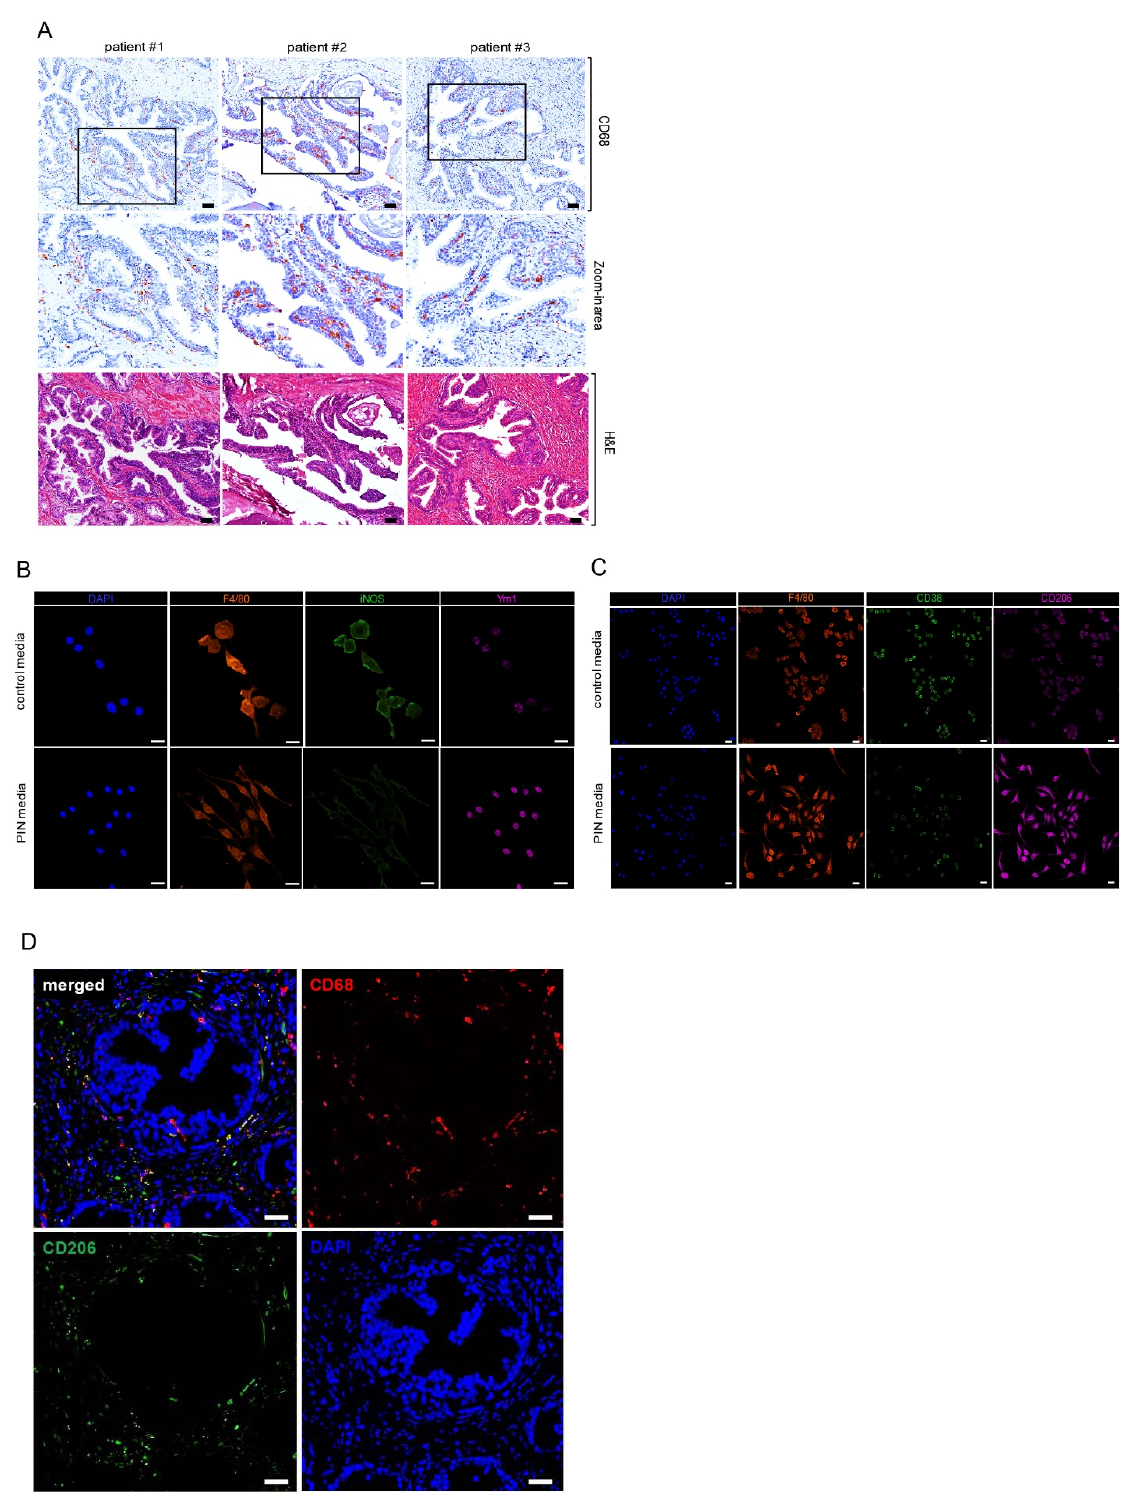
Figure 1. Increased infiltrating macrophages in the prostate intraepithelial neoplasia were M2 subtype. ( A ) Human tissue samples of prostate cancer containing the area of prostate intraepithelial neoplasia (PIN) were immunostained with the antibody of CD68, a pan marker for macrophages (top panel, and middle panel: zoom-in areas). Hematoxylin and eosin (H & E) staining was carried out